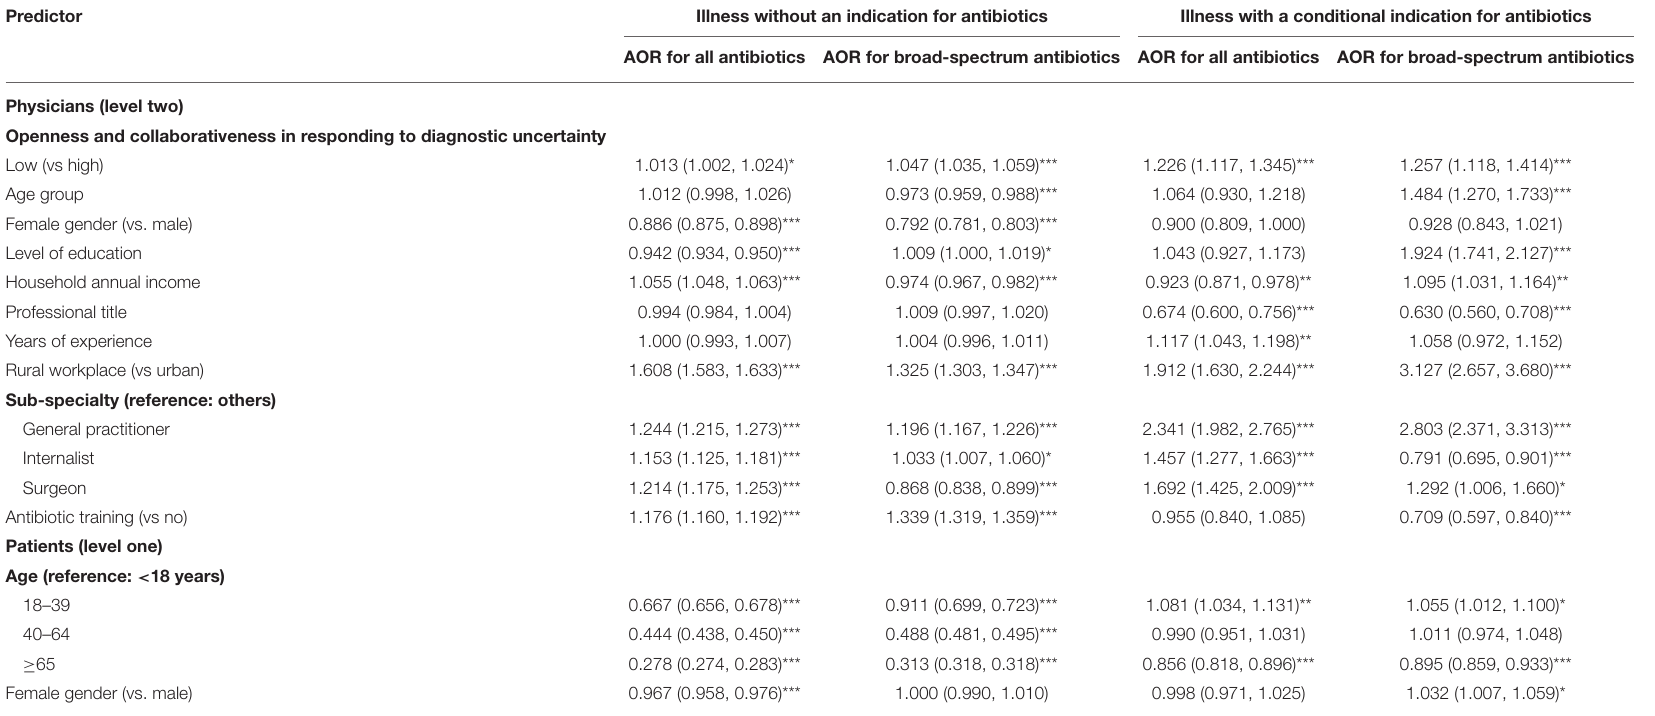
TABLE 3 | Factors associated with antibiotic prescribing—results of multilevel logistic regression modeling.